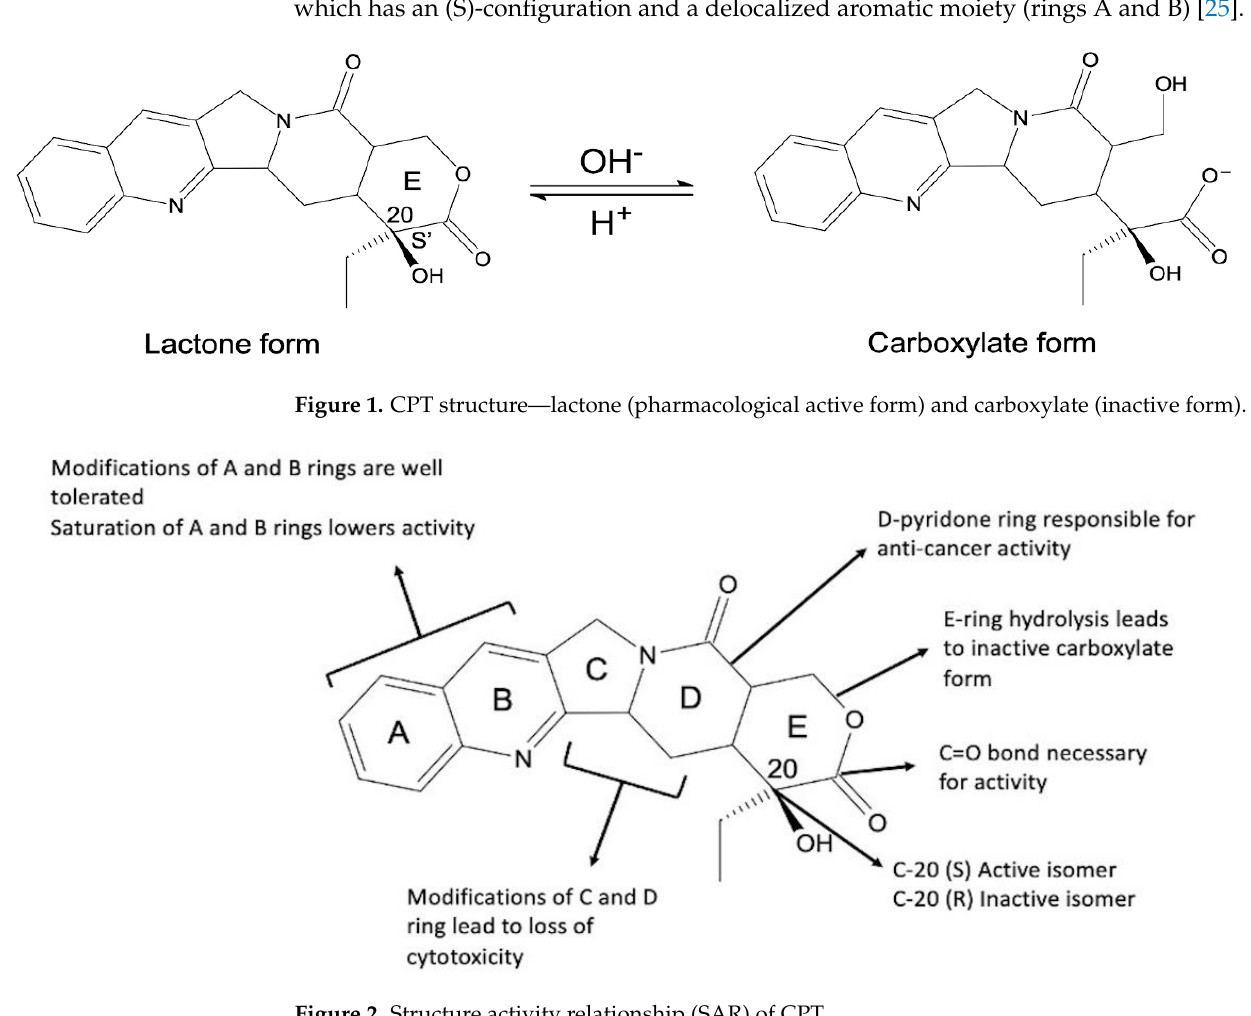
Figure 2. Structure activity relationship (SAR) of CPT.